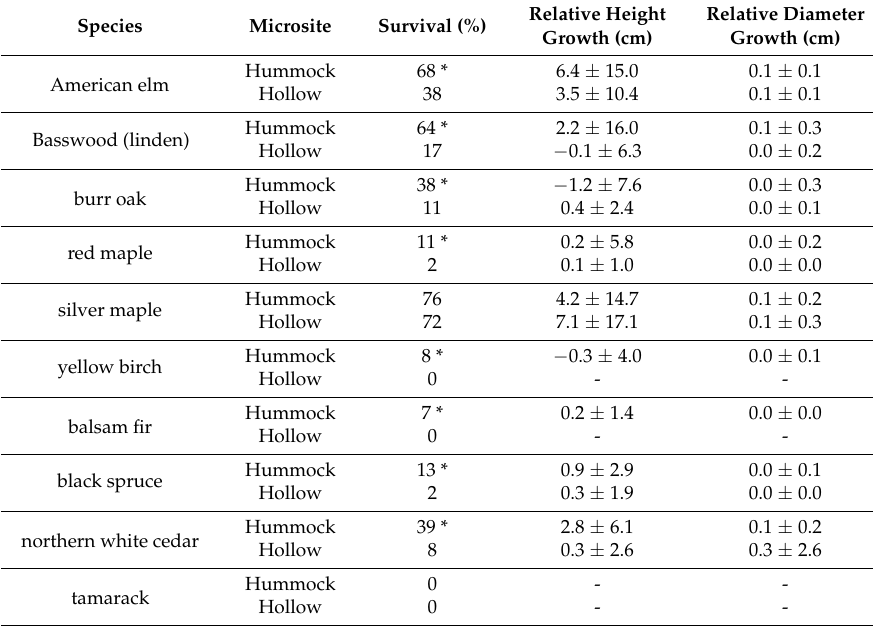
Table 4. Three-year mean seedling survival rate, relative height growth, and relative diameter growth across all treatments by microsite hummock and hollow for each planted species in the Ottawa National Forest study. Statistical significance indicated (*) for hummock vs. hollow comparisons within species for survival. Standard deviations are indicated by ± for height and diameter.